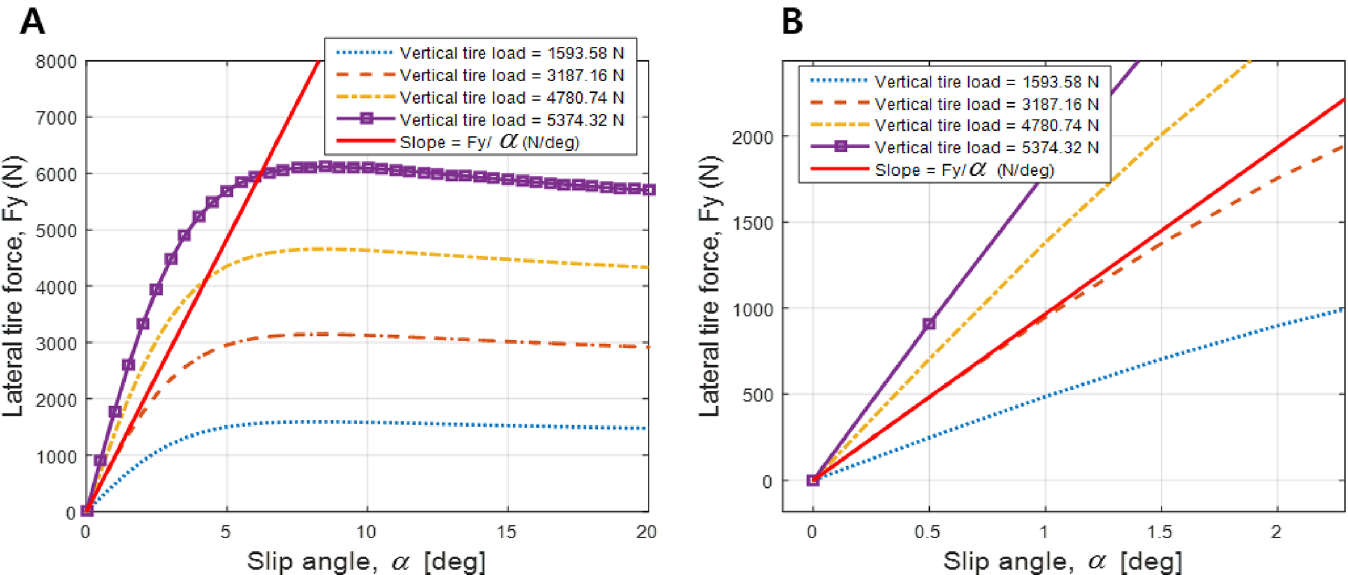
, as a function of the slip angle of the tire, α with different vertical tire loads. (B) the initial slope of y